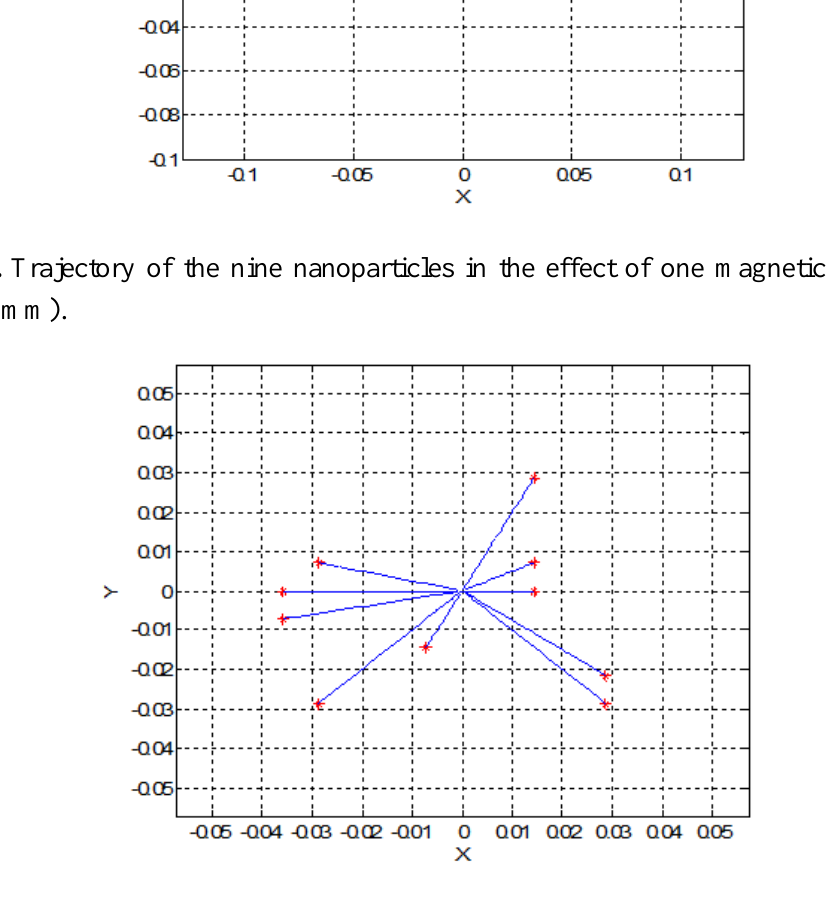
Figure 4. Trajectory of ten nanoparticles in the effect of one magnetic field source (units are